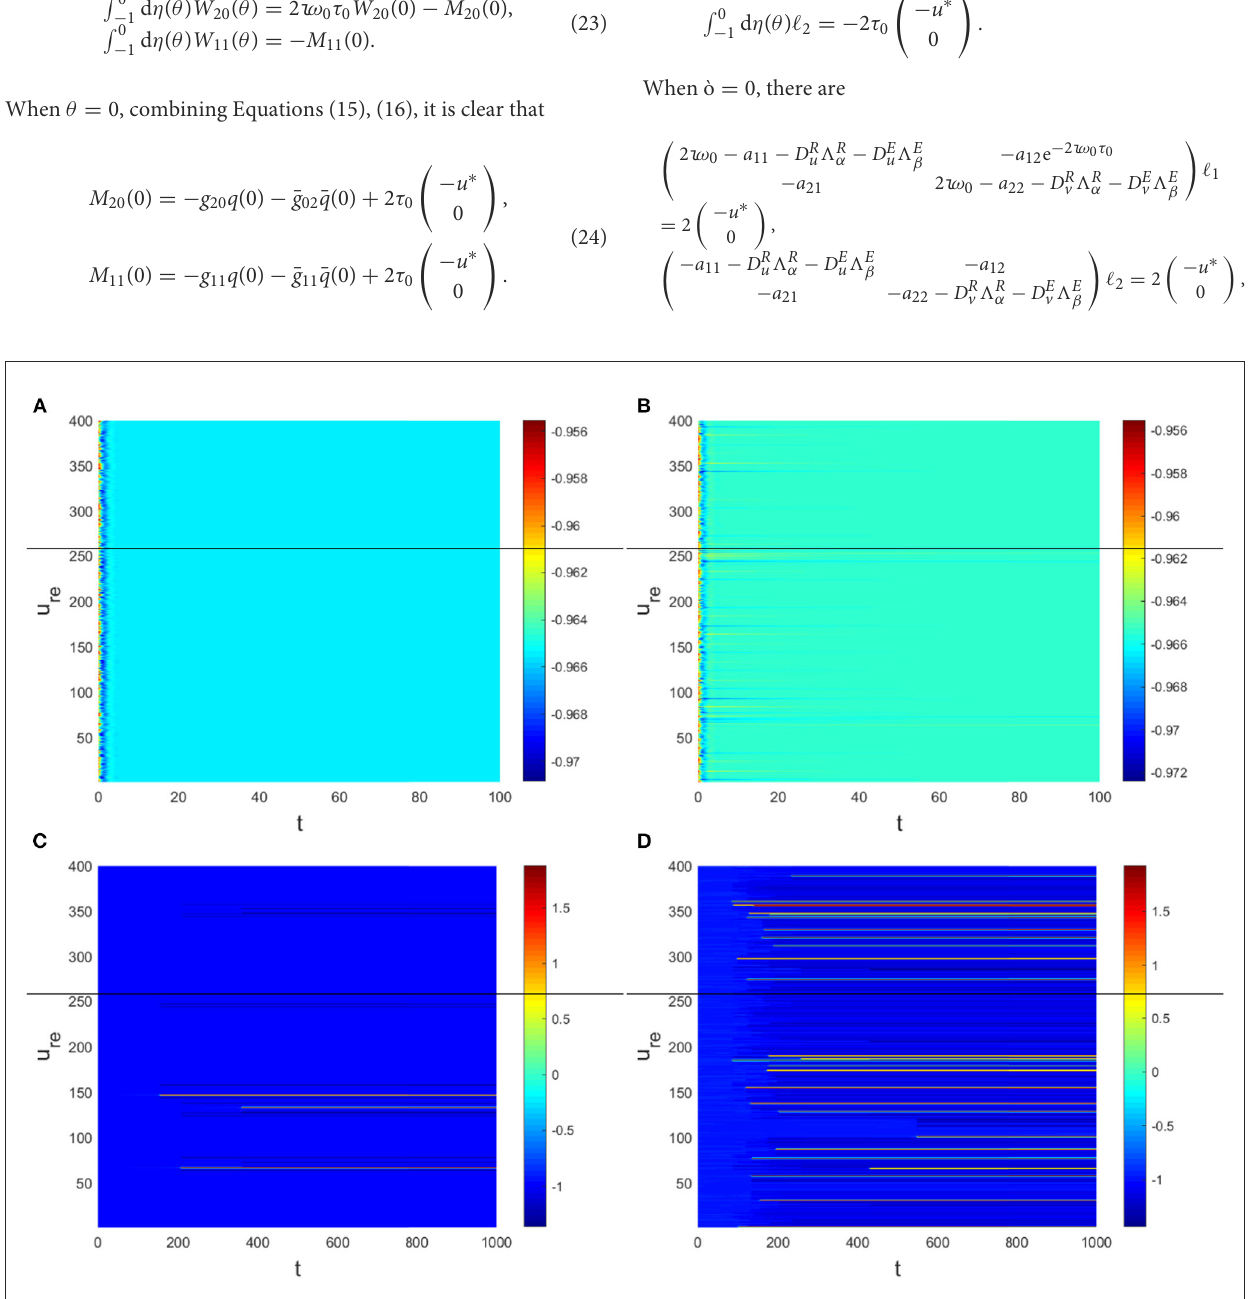
FIGURE5 The corresponding Turing pattern in Figure 4. (A) D v